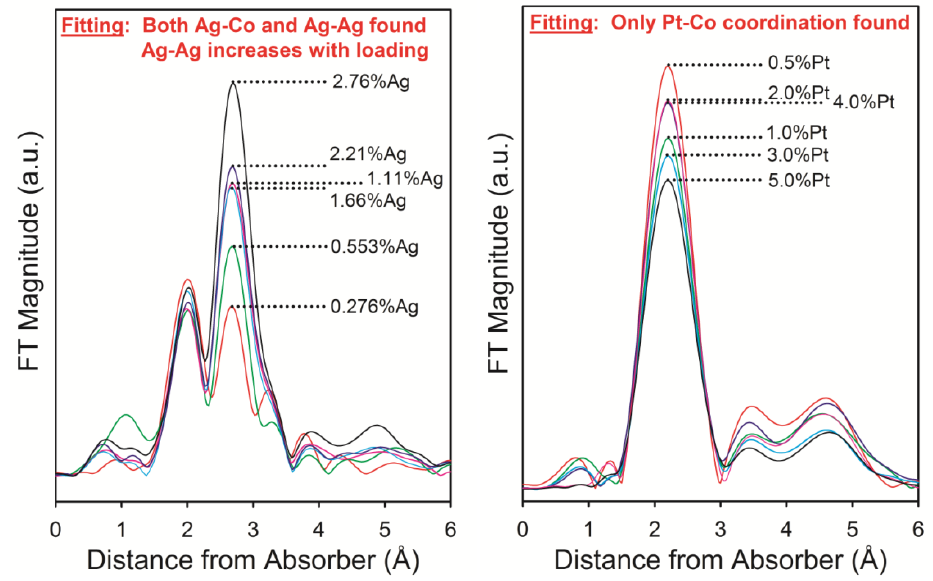
O catalysts having different loadings of Ag 2 3